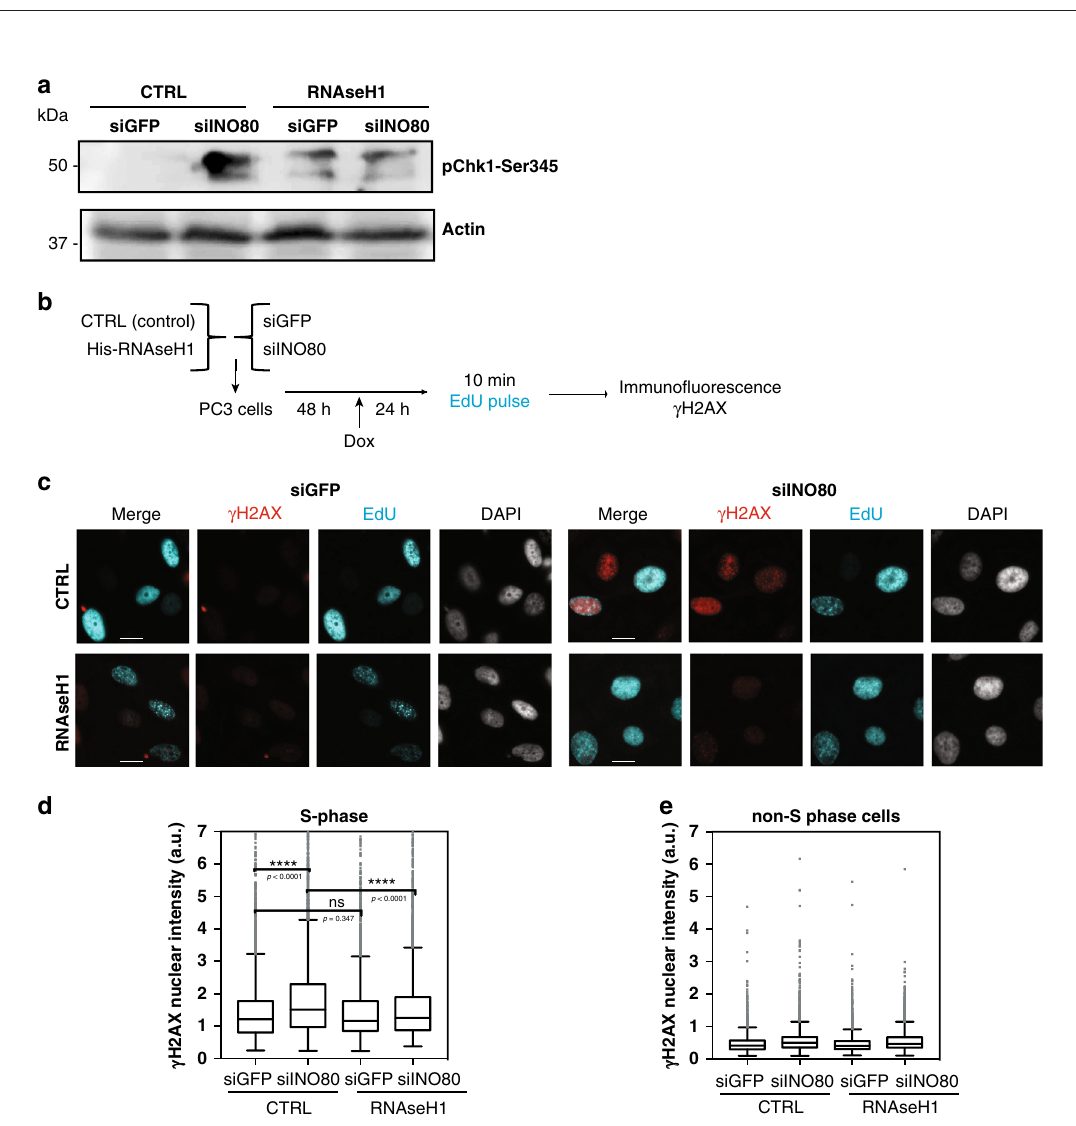
Fig. 2 Fork asymmetry in Ino80-depleted cells depends on R-loops. a Schematic representation of the experimental setup used. PC3 cells were co- transfected with esiRNAs against either GFP (siGFP) or INO80 (siINO80) along with either a control (CTRL) or RNAse H1-overexpressing (RNAse H1) vector. Two days later RNAse H1 expression was induced by doxycycline for 24 h. Cells were labelled with CldU for 20 min (red) followed by IdU pulse for 20 min and subjected to DNA fi bre labelling analysis. b Representative pairs of sister replication forks were assembled from different fi elds of view and were arbitrarily centred on the position of origin. Scale bar 5 μ m. Similar distribution of paired forks was observed in three independent experiments. c Scatter plots of the distances covered by right-moving and left-moving sister forks during the CldU pulse in Ino80-pro fi cient or de fi cient cells expressing or not RNAse H1. The central areas delimited with grey lines contain sister forks with less than a 25% length difference. The percentage of symmetric forks is indicated. d Relative fork asymmetry. Fork asymmetry is expressed as the ratio of the longer arm to the shorter one for each pair of sister replication forks, **** p -value < 0.0001; n.s non-signi fi cant (two-tailed unpaired Student ’ s t - test). Numbers above boxes indicate the median of the ratio of the longer to shorter arm. Data is presented as Tukey boxplot.